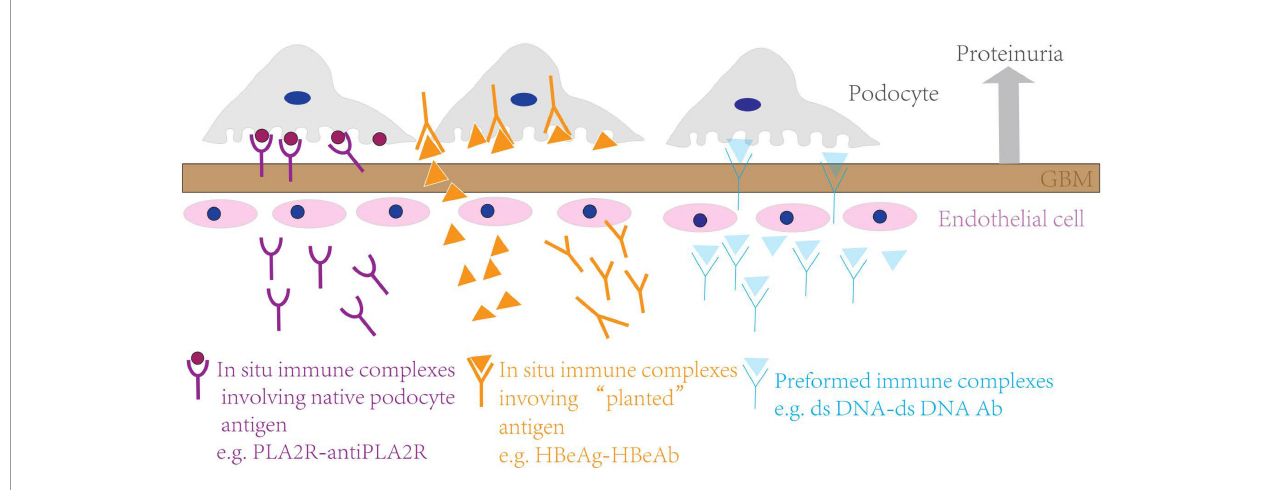
FIGURE 2 | Pathogenesis of